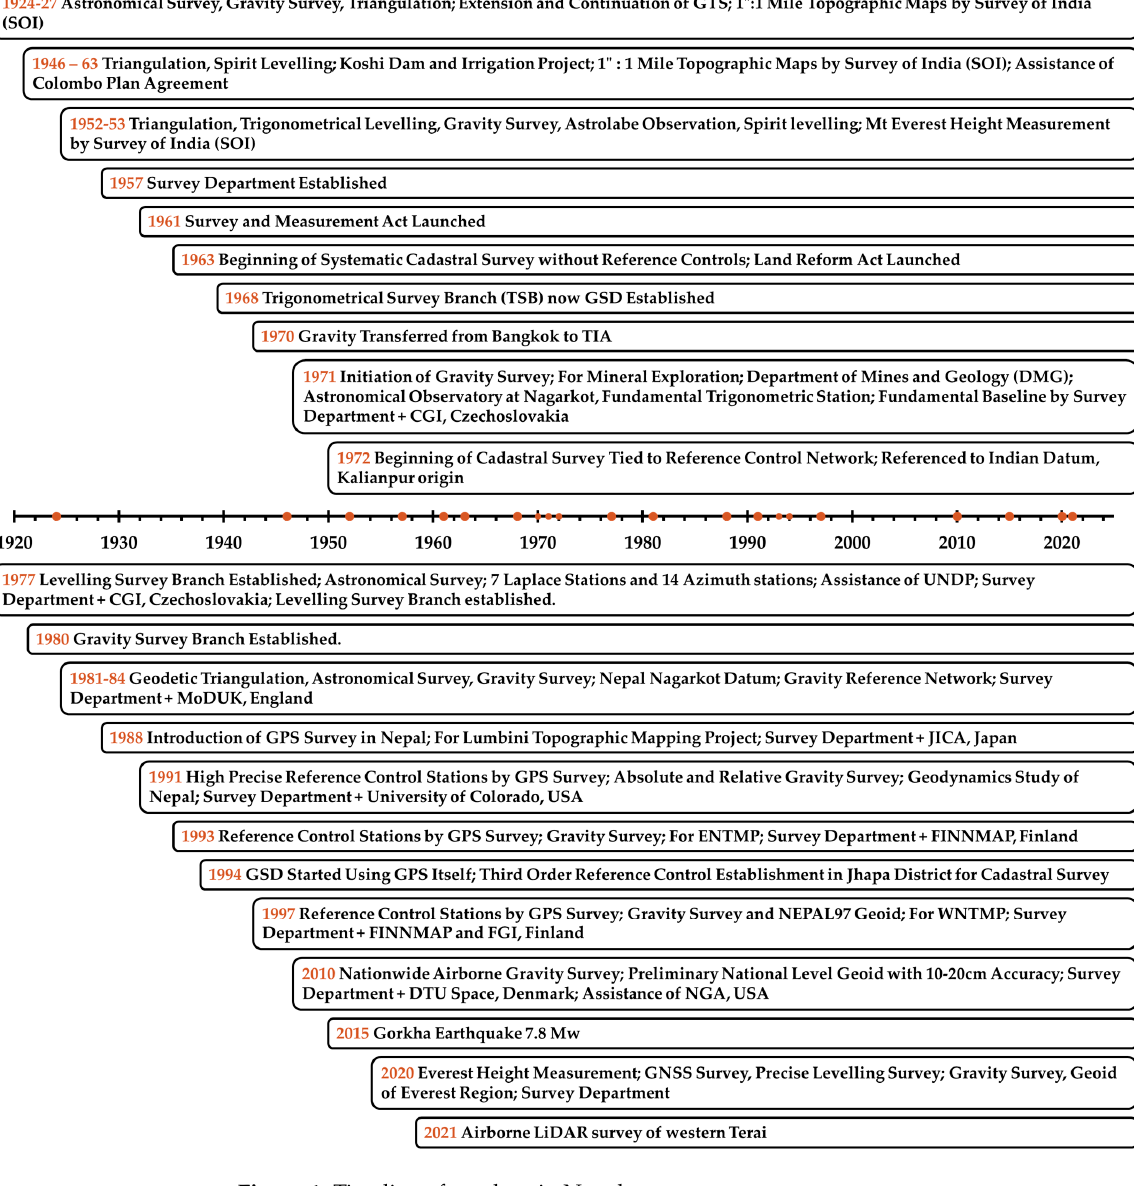
Figure 1. Timeline of geodesy in Nepal.